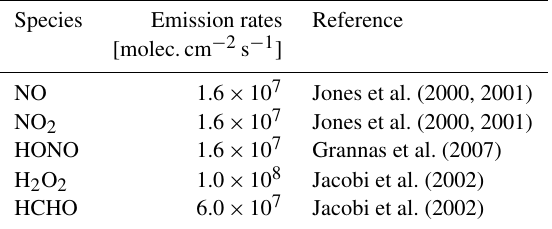
Table 2. Emission fluxes from the underlying surface (Cao et al.,